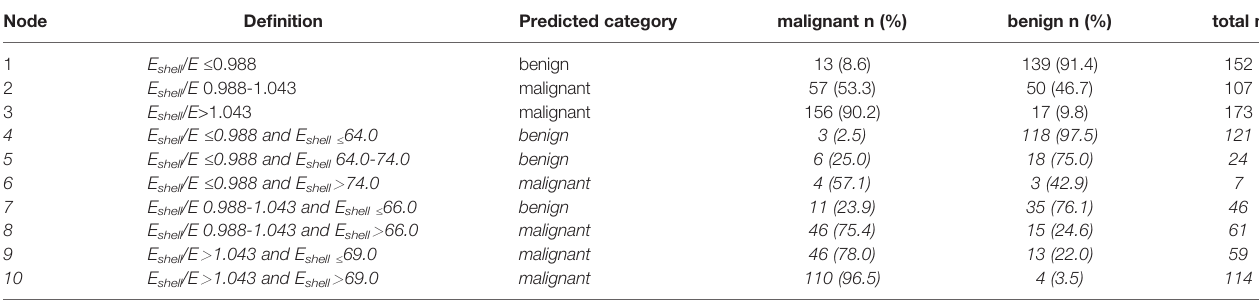
TABLE 4 | Characteristics of the nodes of the classi fi cation algorithm.